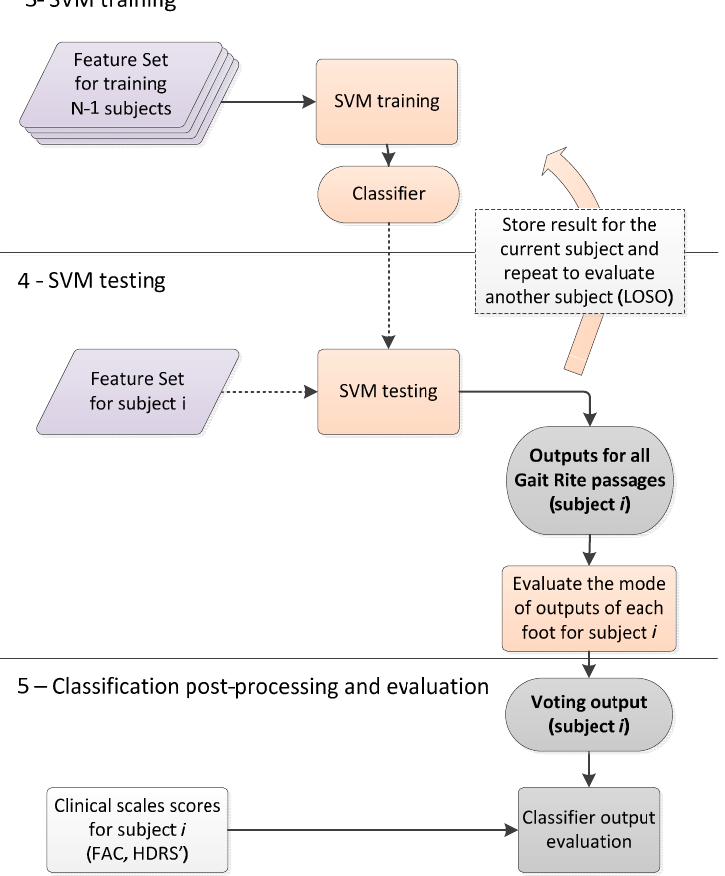
Figure 3. Block scheme of the SVM classifier validation. The LOSO approach was followed: data from N -1 subjects were used for training and the obtained classifier was tested on the features from the remaining subject.